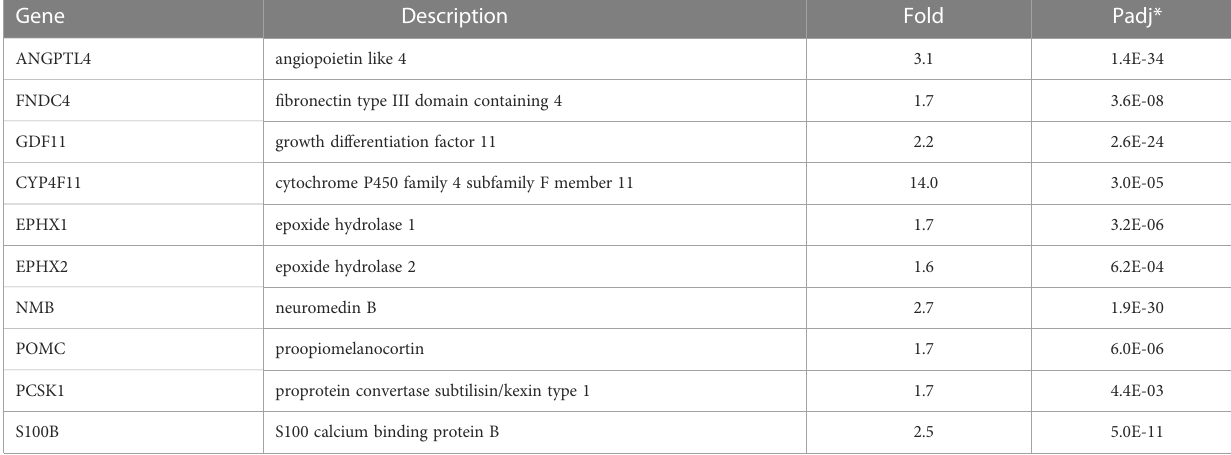
TABLE 2 Genes encoding secreted lipokines and peptides upregulated by NRBC. Gene